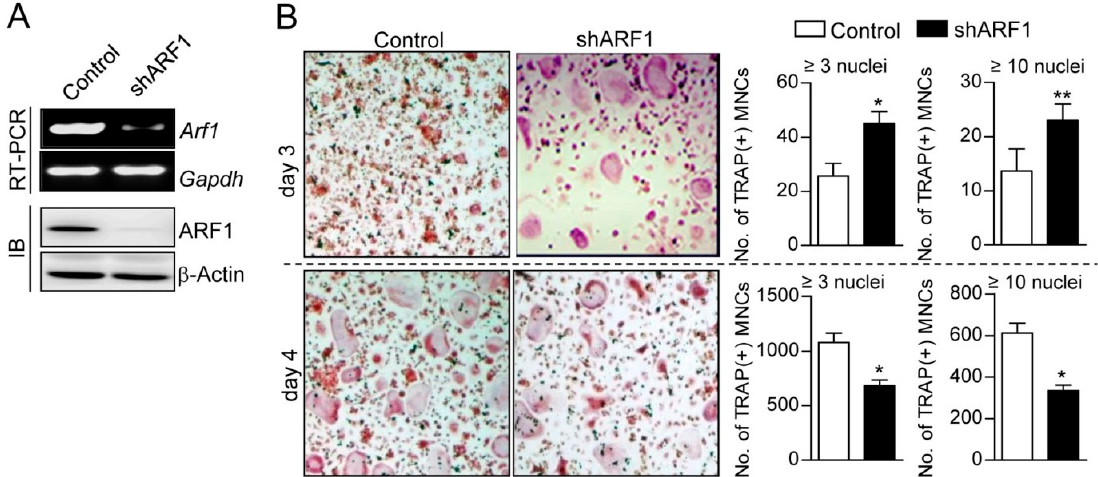
Figure 2. Effect of ARF1 depletion on osteoclast differentiation. ( A ) Osteoclast precursors were infected with shRNA lentiviral particles targeting mouse ARF1 or pLKO.1-puro empty control virus particles. After puromycin selection for 2 days, ARF1 knockdown was confirmed using RT-PCR and immunoblot assay (IB). Glyceraldehyde 3-phosphate dehydrogenase (Gapdh) and β -actin were used as loading controls; ( B ) ARF1-depleted cells with 70% confluence (2 × 10 4 cells/well) were cultured in 48-well plates and incubated in the presence of M-CSF (30 ng/mL) and RANKL (100 ng/mL) for 3 or 4 days. Tartrate resistant acid phosphatase (TRAP)-positive multinucleated cells [TRAP(+) MNCs] representing more than 3 or 10 nuclei were counted and photographed using a light microscope. The experimental data are expressed as mean ± SD ( n = 3) and the results shown are representative for at least three independent experiments. * p < 0.01, ** p < 0.05.